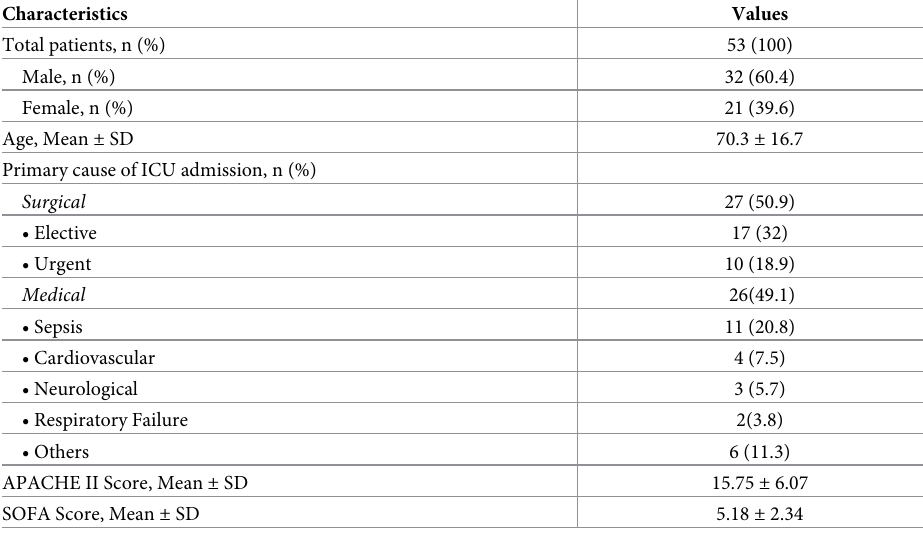
Table 1. Demographic profile of the